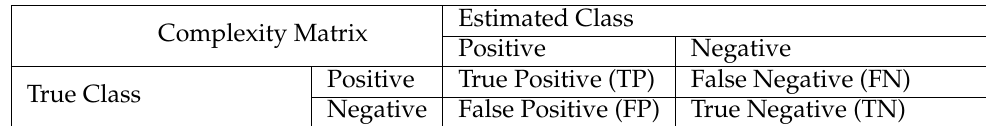
Table 3. General Form Of Complexity Matrix.